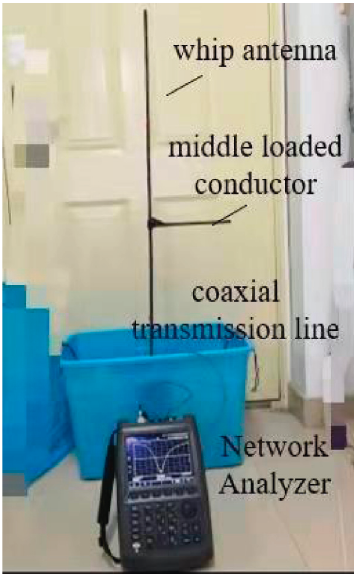
Figure 7: Experimental diagram of the reflection coefficient test of the self-made midload whip